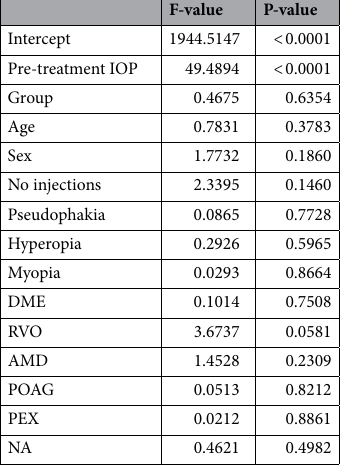
Table 4. Random intercept model with confounding factors. AMD age-related macular degeneration, DME diabetic macular edema, NA narrow angles, No Injections Number of injections in the course of therapy, POAG